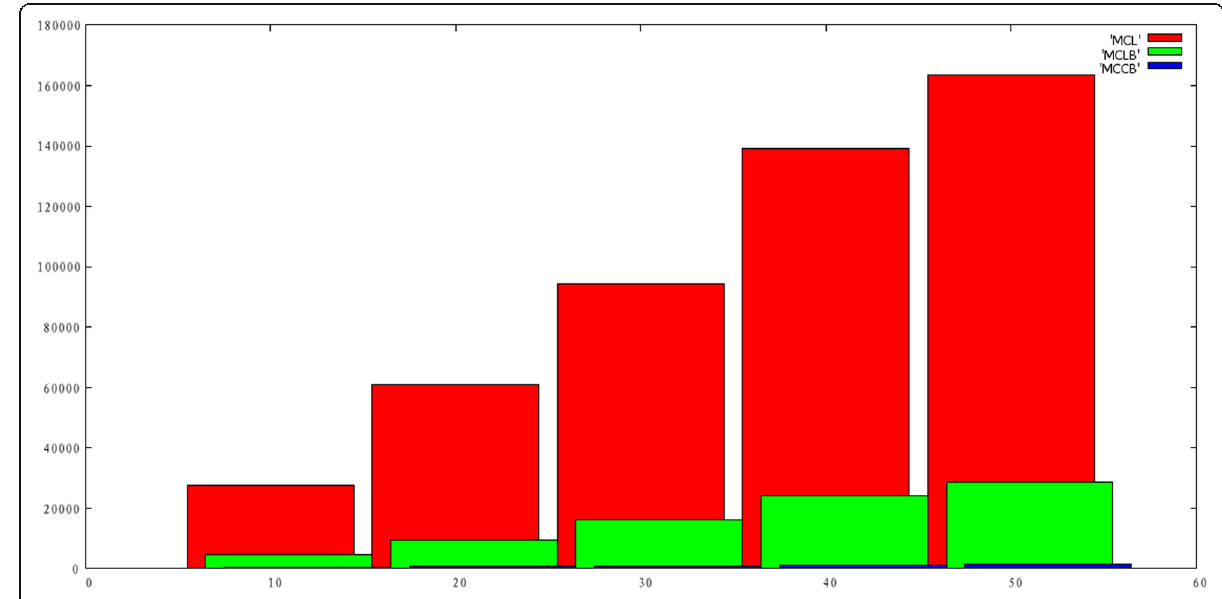
Fig. 10 Algorithm running time comparison chart. The red is for MCL positioning uptime, green for MCB positioning uptime, and blue CMCL positioning uptime. As can be seen, CMCL is much smaller than the other two positioning